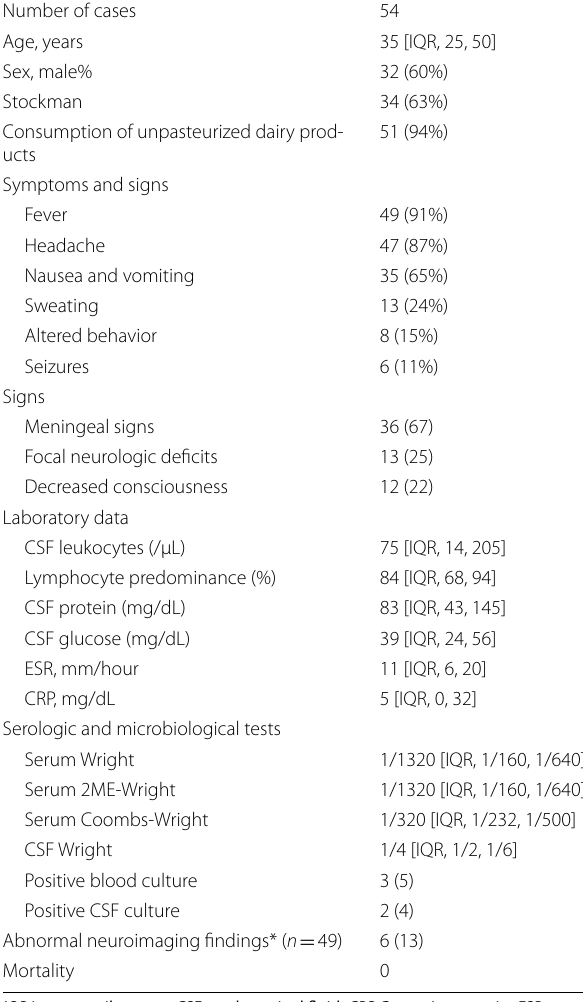
Table 1 Characteristics of patients